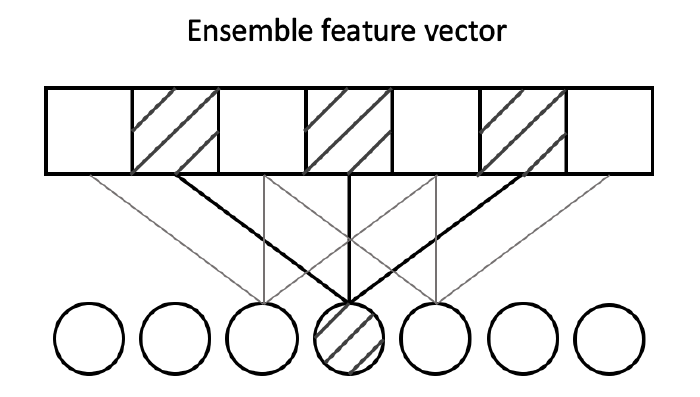
Figure 4. An example of Atrous one-dimensional convolutions (one layer) with dilation rate equal to 2: A 3 1 kernel with a dilation rate of 2 has the same field of view as a 5 × a wider field of view with the same computational